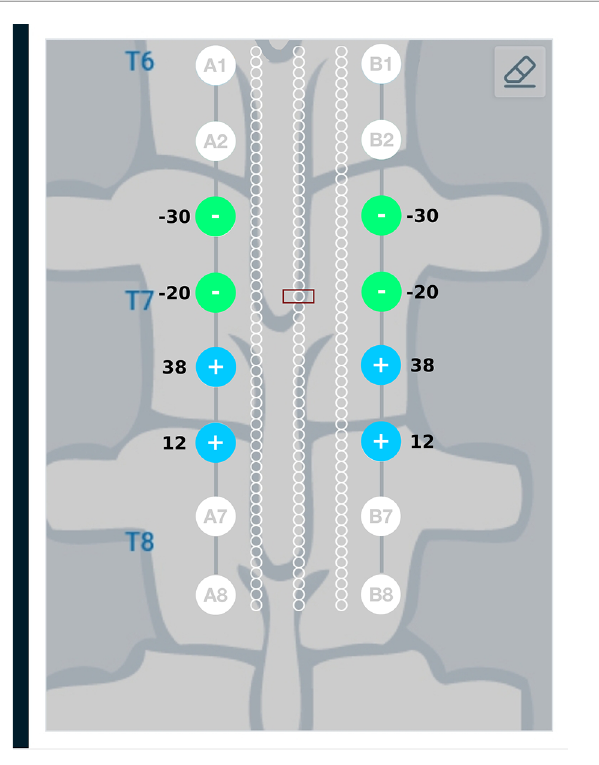
FIGURE 11 Current steering results graphically represented on the user interface. For the target region located at an equal distance from the two leads, the optimal electrode excitation shows that the current sourced/sunk from lead A and lead B is